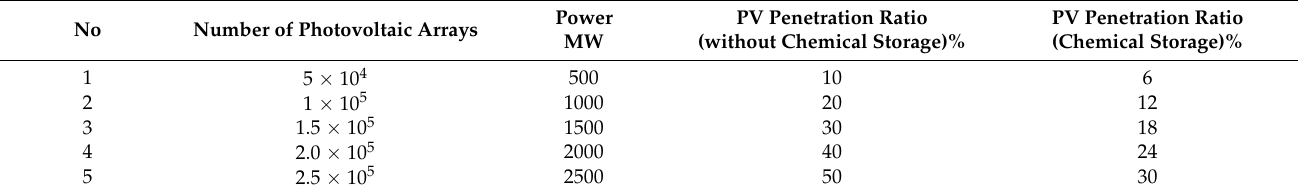
Table 1. Number of PV access arrays, power, and penetration